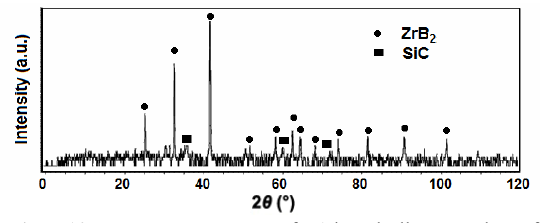
Fig. 10 XRD pattern of 1 kg bulk sample of (ZRBC2.5+15 wt% Si+30 wt% Mg) after FT assisted reaction and leaching with HCl acid.